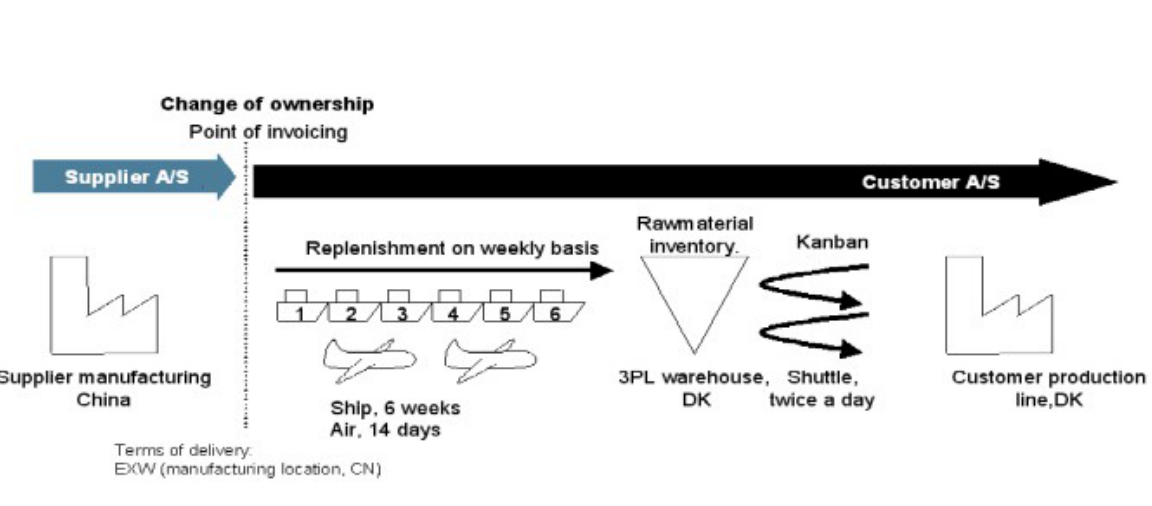
Figure 1. The supply chain setup before the VMI